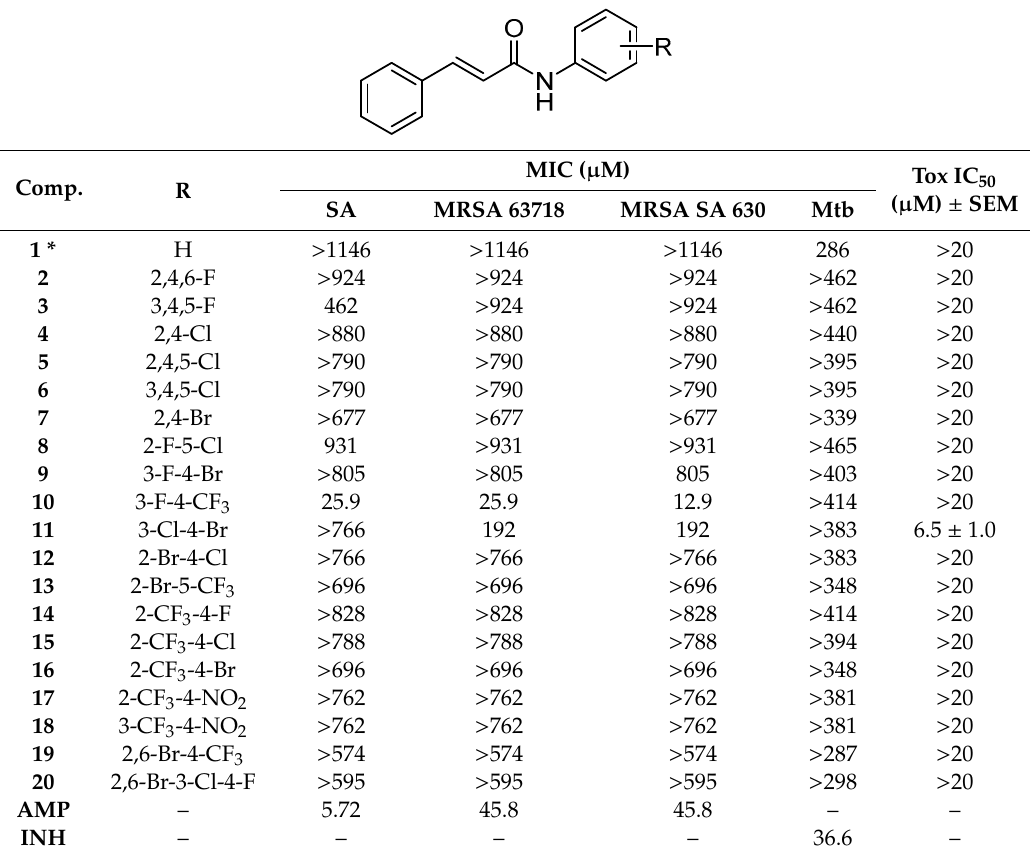
Table 1. Structure of ring-substituted (2 E )- N -aryl-3-phenylprop-2-enamides 1 – 20 , in vitro anti- Staphylococcus activities’ minimum inhibitory concentration (MIC; µM) in comparison with standard ampicillin (AMP), in vitro antitubercular activity MIC ( µ M) in comparison with standard isoniazid (INH), and their influence on viability of THP1-Blue ™ NF- κ B cell line (IC 50 ( µ M) ± SEM, n = 6).